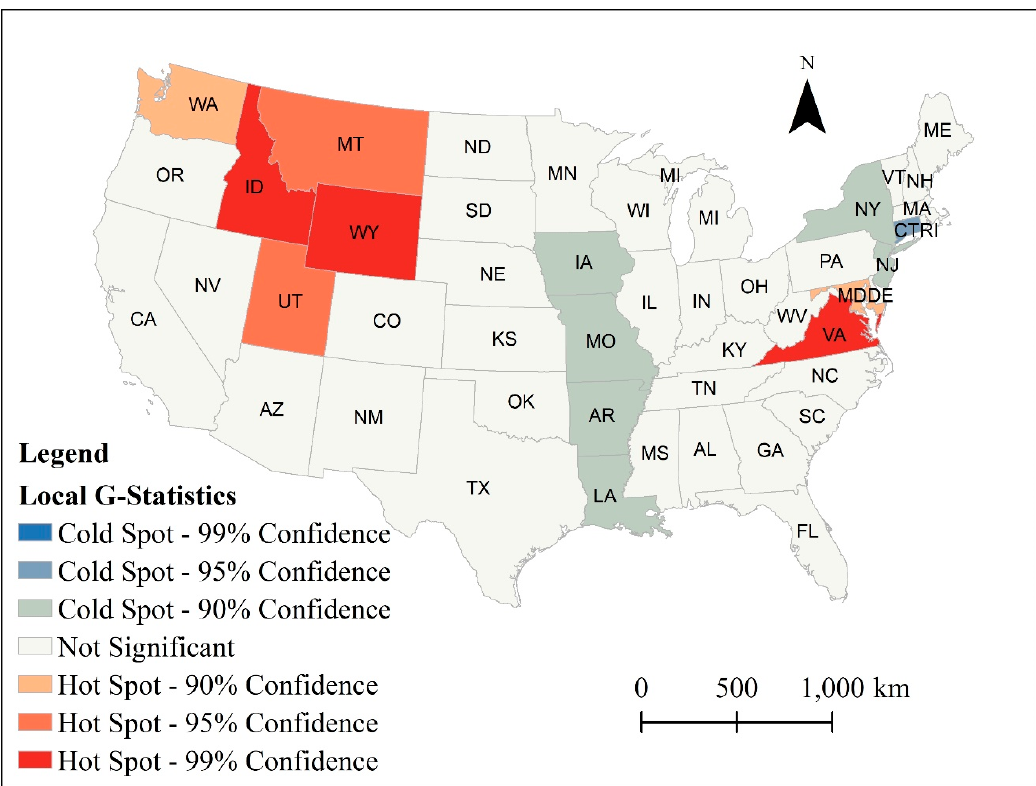
Figure 10. The results of local G-Statistic analysis.